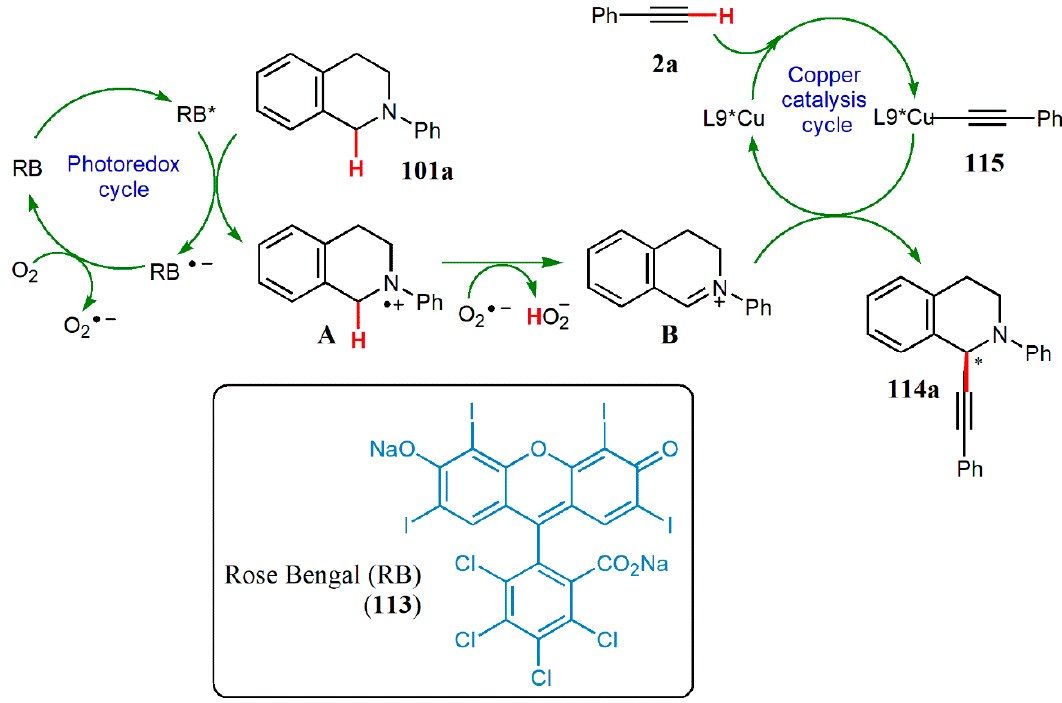
Figure 36. The mechanism proposed for the cooperative organo-photocatalysis in the CDC of THIQs and alkynes.